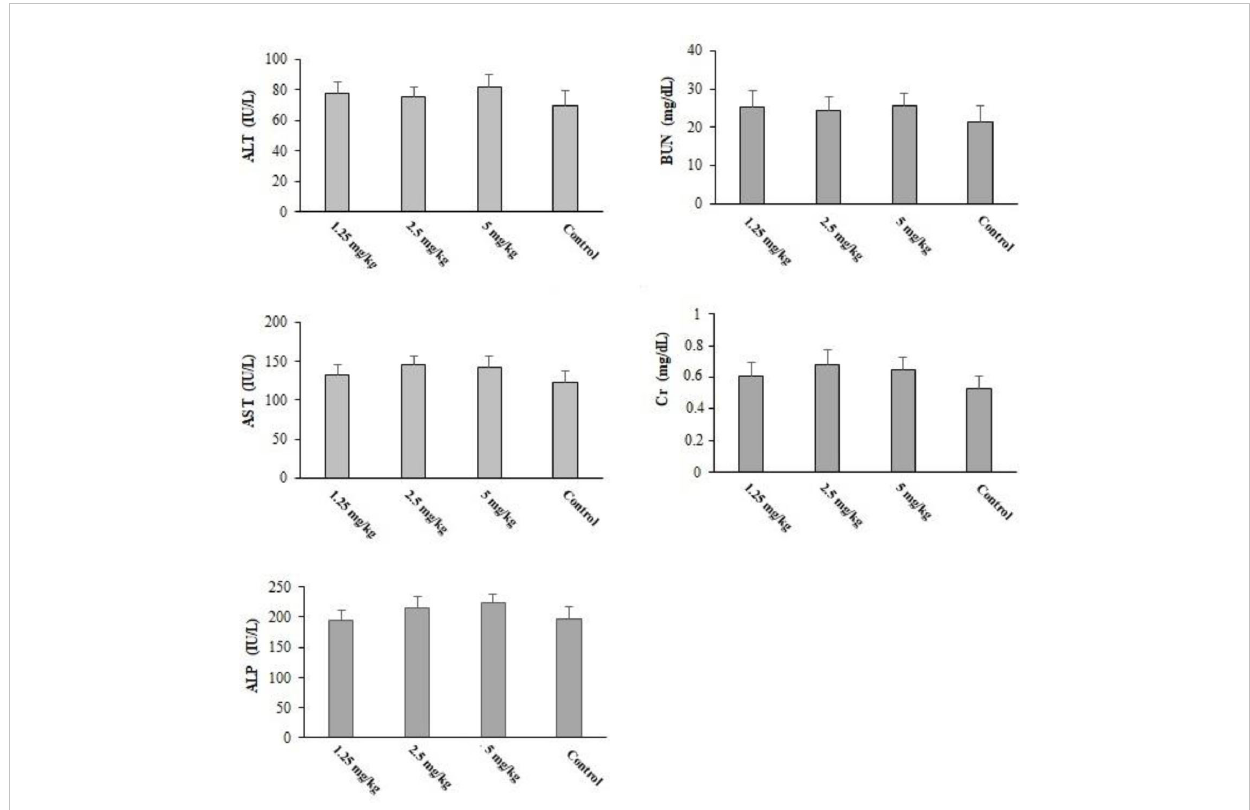
FIGURE 9 The serum level of some biochemical factors after oral administration of Curcuma longa essential oil (CLE) at the doses of 1.25, 2.5, and 5 mg·kg − 1 ·day − 1 for 14 days. ALT, alanine aminotransferase; AST, aspartate aminotransferase; ALP, alkaline phosphatase; Cr, creatinine; BUN, blood urea nitrogen. Data are expressed as the mean ±